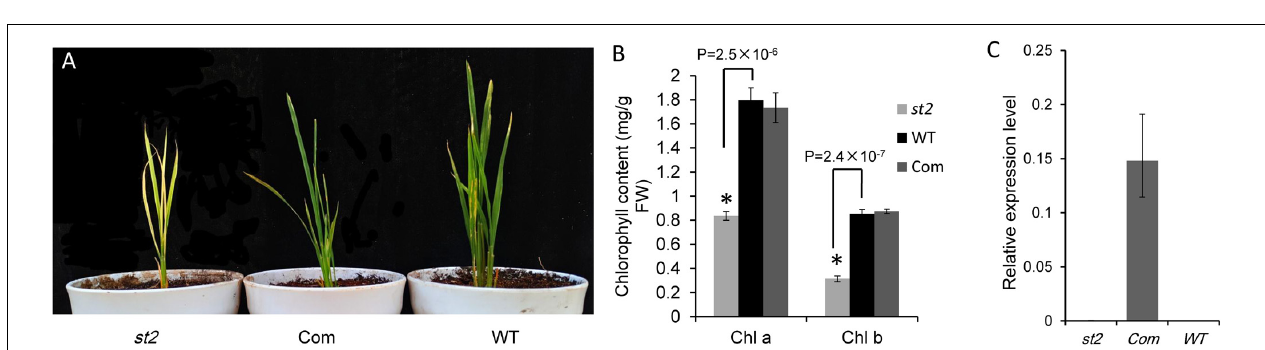
FIGURE 4 | (A) Genetic mapping of the SiSTL2 locus. In top panel, Y-axis means the (cid:49) SNP index, X-axis means physical location. Red lines show the (cid:49) SNP indexes of different SNPs on chromosome. Gray box shows the candidate region obtained by MutMap+. The bottom panel indicates that the gene is narrowed to a 1.009 Mb region between Ins9-1 and b171 by 120 F 2 individuals. (B) The top of the figure shows the gene structure. Black boxes, exons; gray boxes, UTRs; gray lines, introns. The bottom of the figure shows the transcript variation proved by sequencing. Left bottom: gray text, intron; black text, exon; red lines, mutant position. Right bottom: the blue boxes and gray box show the mutant positions in genome sequence and transcript sequence, respectively. (C) The conserved functional domain and motifs of the SiSTL2 protein. Gray triangles show the six catalytic motifs, black triangles show the four Zn binding sites, and red arrows show the mutant position. (D) 3D protein structures of SiSTL2 (WT homo-hexamer) and (cid:49) SiSTL2 (mutant protein).